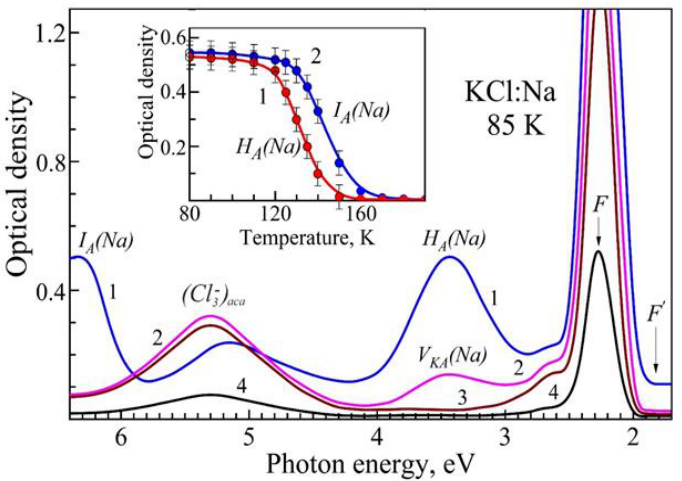
Figure 2. Absorption spectra measured for a freshly grown KCl:Na (1000 ppm) crystal just after the exposure to X-rays (20 mA, 45 kV, W-anticathode) at 85 K for 3 h (curve 1) and after additional preheating to 170 K (curve 2) and 300 K (curve 3). The absorption spectrum measured for a pure KCl crystal after isodose irradiation at 85 K (curve 4). All absorption spectra were recorded at 85 K. The insert shows the annealing curves for the I A (Na) and H A (Na) center concentrations via the 6.35 eV and 3.5 eV bands, respectively (for details see the text).